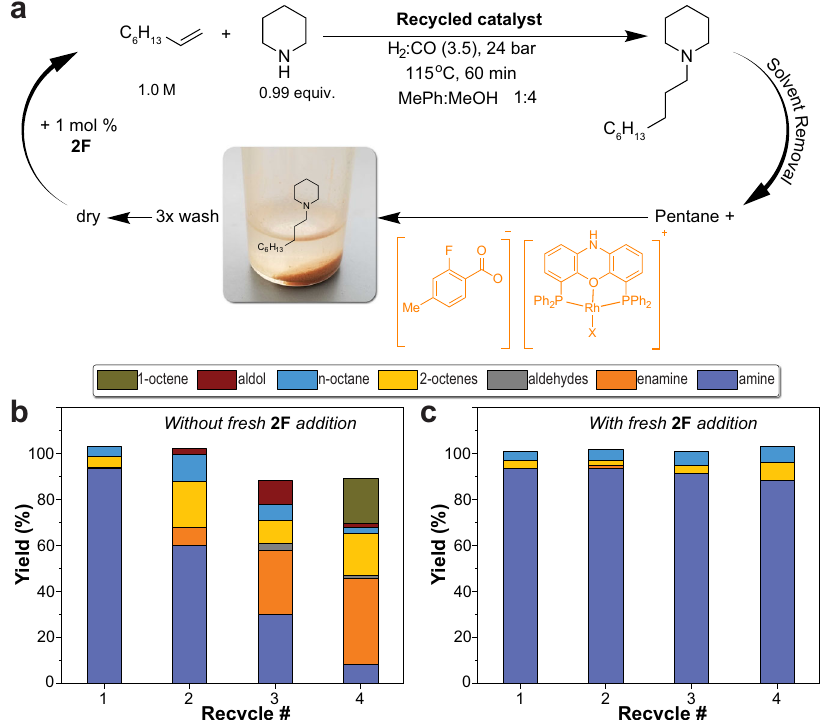
Fig. 5 Catalyst recycling scheme. a Schematic of the developed catalyst recycling process. HAM performance of the Rh/N-Xantphos catalyst recycled without ( b ) and with c the addition of